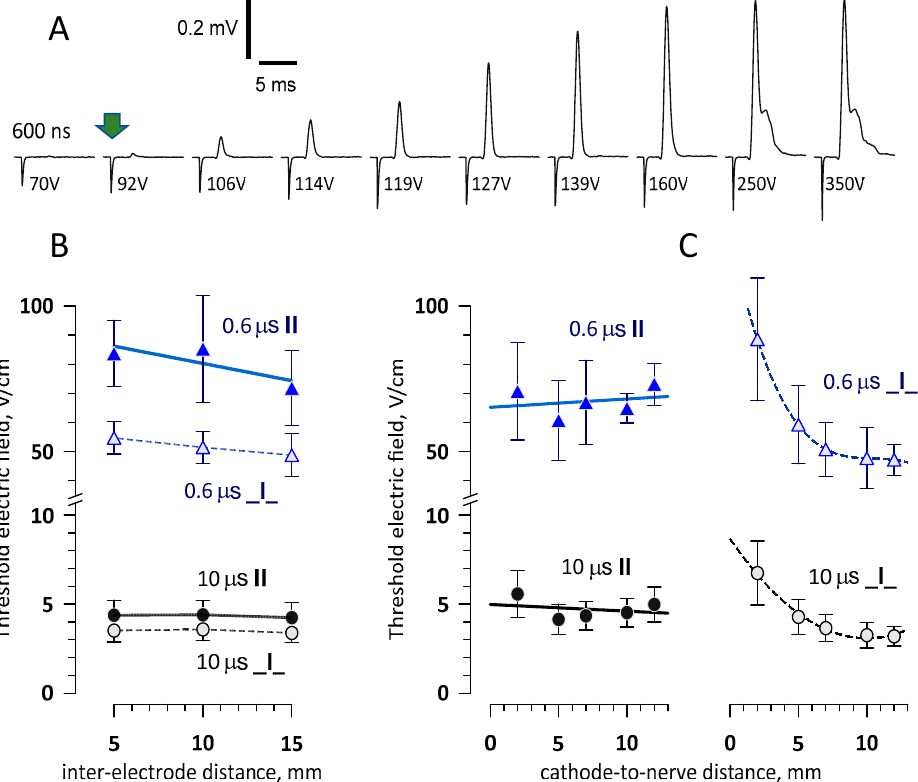
Figure 1. Sample traces of the compound action potentials (CAPs) evoked in a frog sciatic nerve ( A ) and the effect of the stimulating electrode placement on the excitation threshold ( B , C ). ( A ) The nerve was submerged in the physiological solution and stimulated with a bipolar electrode by a single 600-ns pulse at the indicated voltage. The arrow identifies the stimulation threshold when the CAP amplitude reached about 20 µ V. ( B ) The effect of the inter-electrode distance on the electric field threshold for 0.6- µ s and 10- µ s pulses. The electrodes were placed 7 mm from the nerve either parallel ( II ) or perpendicular ( _I_ ) to it. The cathode was closer to the recording electrodes ( II ) or closer to the nerve ( _I_ ). ( C ) The effect of the cathode-to-nerve distance for the II and _I_ placements of the electrodes. The inter-electrode distance was 15 mm. Mean values ± SE, n = 5.